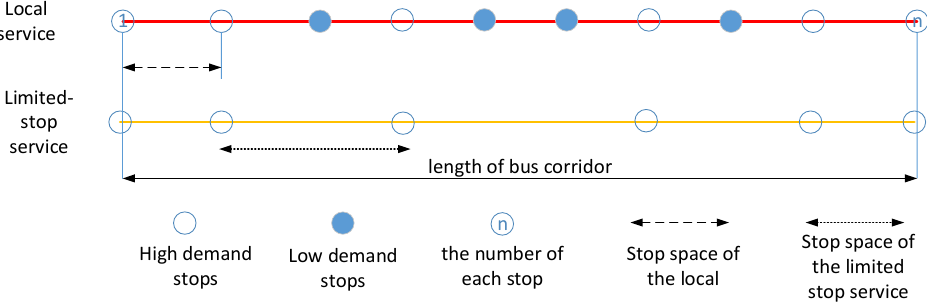
Figure 1. Stopping patterns associated with a fixed-route service.